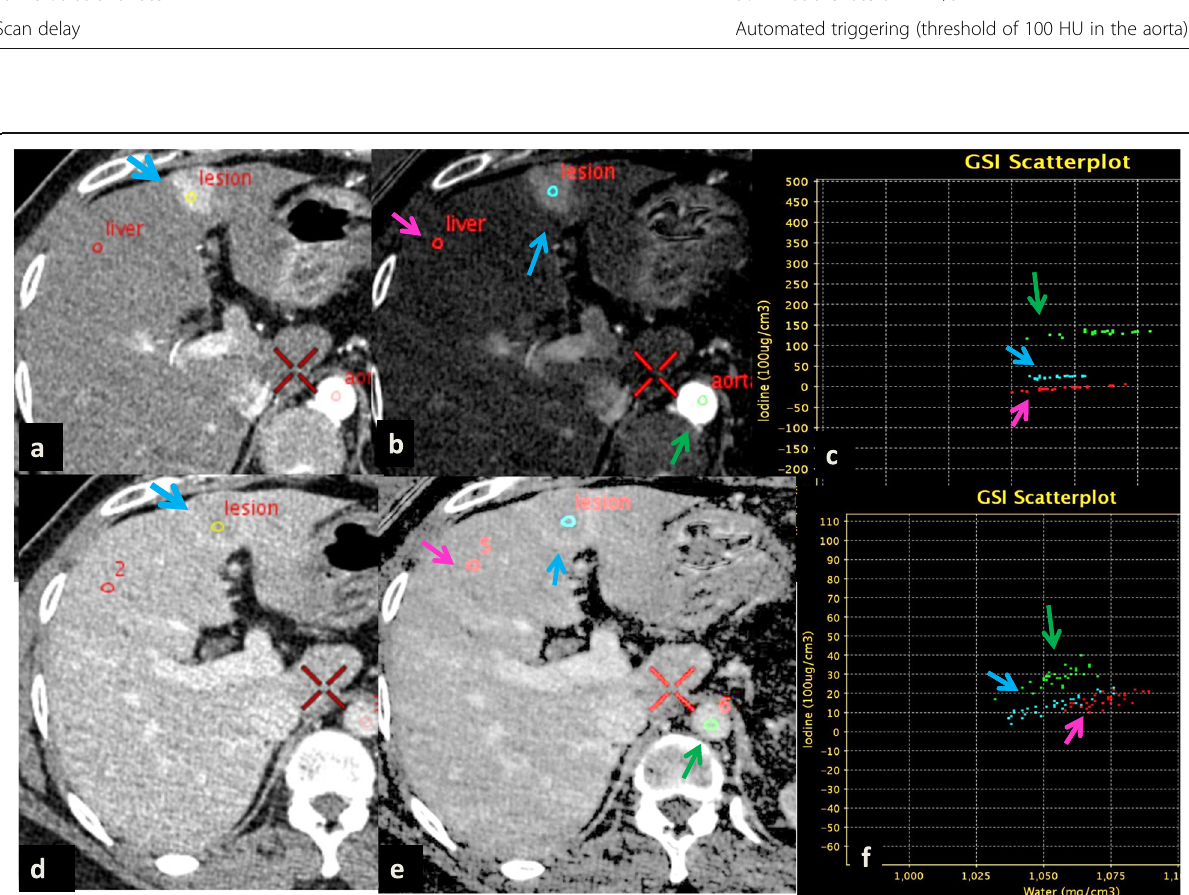
Fig. 2 Spectral computed tomography (SCT) of a patient with cirrhosis and hepatocellular carcinoma depicting polychromatic, material density (MD) map, and scatter plots. a Arterial phase axial polychromatic image showing well-defined subcapsular hypervascular lesion (HCC), measuring 2.4 cm in segment IV (blue arrow). b Iodine density map showing ROI (blue circle) within lesion to calculate ICD nodule HAP (blue arrow), ROI in the liver (red circle) to measure ICD liver HAP (pink arrow), and ICD aorta (green arrow). c Scatter plot depicting the highest iodine density value of the aorta (green arrow), lesion iodine density (blue arrow) less than the aorta but more than the background liver (pink arrow). d Portal venous phase polychromatic image showing segment IV lesion depicting washout (yellow circle) with capsular enhancement (blue arrow). e Corresponding iodine density map showing ROI within lesion (blue circle) to calculate ICD nodule PVP, ICD aorta PVP (green circle), and ICD liver PVP (pink circle). f Scatter plot depicting the highest ICD aorta PVP (green arrow), ICD nodule PVP (blue arrow) showing a decreasing trend of iodine density compared to the background liver (pink